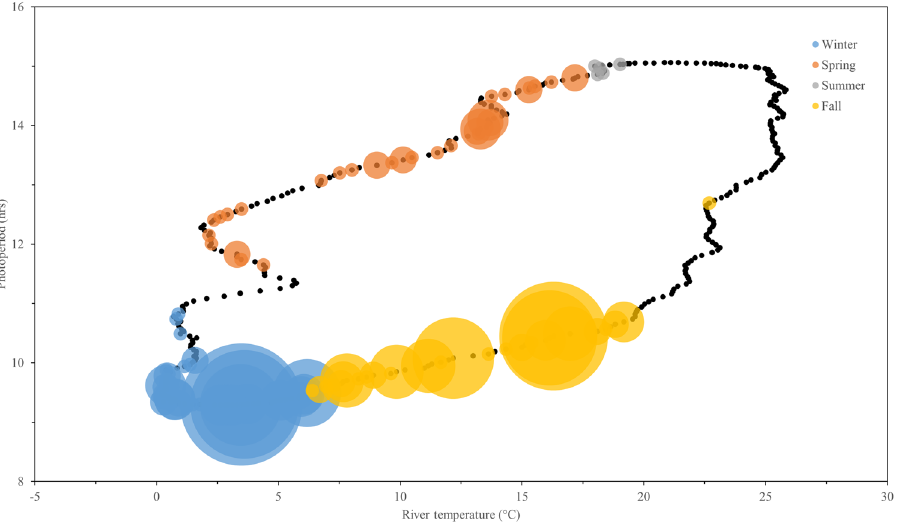
Figure 6. Interaction between photoperiod and water temperature in the Hudson River estuary, New York, during 2017. Circle size represents the daily unique count of Atlantic Sturgeon in the New York Wind Energy Area study site (Equinor, Lease OCS-A 0512). Water temperature is from the USGS Gauging Station 01372058 at Hudson River below Poughkeepsie, New York. Winter = December 1–February 28; Spring = March 1–May 31; Summer = June 1–August 31; Fall = September 1–November 28.